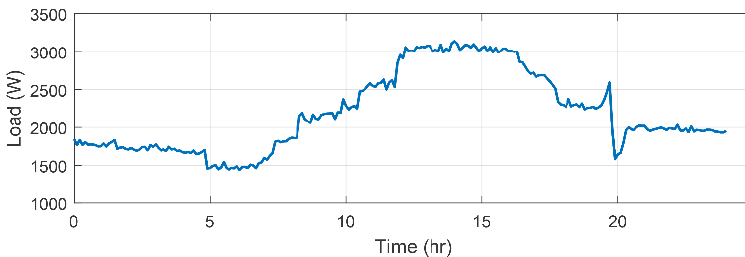
Figure 13. Solar irradiation, ambient temperature and wind speed of July 28th, 2016, in Dhahran.